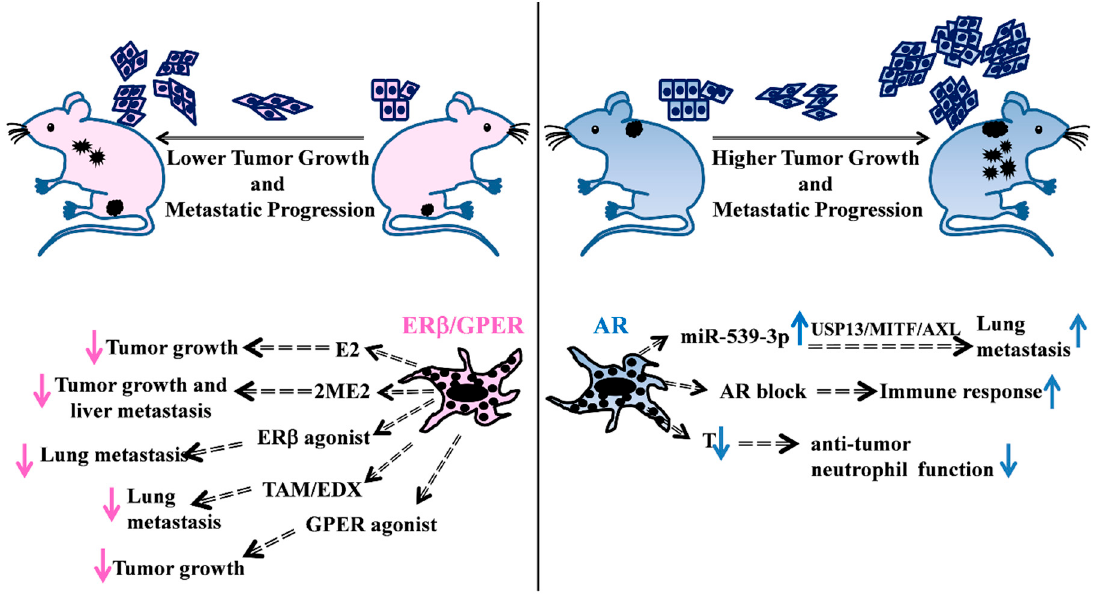
Figure 1. Schematic overview of some representative in vivo studies supporting the hormonal involvement in melanoma disease. ( Left ) Evidences of female hormonal treatments in in vivo mice models. E2 treatment of castrated mice s.c. injected with ER positive melanoma cells reduces tumor growth [47]. 2ME2 treatment of SCID mice, previously intrasplenically injected with melanoma cells, decreases primary tumor growth and liver metastasis number [49]. Treatment of melanoma cells with GPER agonist a ff ects tumor growth in host mice improving response to immunotherapy [54]. Administration of the ER β agonist LY500307 in female mice, previously i.v. injected with melanoma cells, decreases lung nodules [55]. Oral administration of TAM [56] and EDX [57] exert inhibitory e ff ects on tumor metastatization into the mouse lungs. ( Right ) AR action is responsible for the increased number of lung metastases through the miR-539-3p / USP13 / MITF / AXL axis [58], whereas AR blockade mediates an increase in the immune response [59]. T loss in castrated male mice causes a decrease in the anti-tumor neutrophil function [60]. E2: 17 β -estradiol; 2-ME2: 2-methoxyestradiol; TAM: Tamoxifen; EDX: endoxifen; USP13: ubiquitin specific peptidase 13; MITF: microphthalmia-